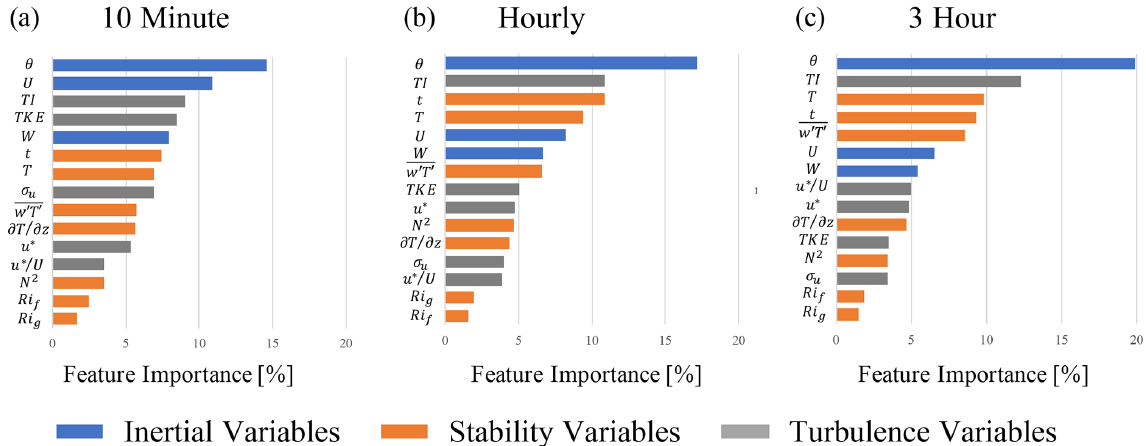
Figure 4. Feature importance for the prediction of exogenous error when all input features are given to the random forest model. Panel (a) shows importance for the 10min prediction, panel (b) shows importance for the hourly prediction, and panel (c) shows importance for the 3h prediction. Blue bars denote inertial variables, orange bars denote stability variables, and gray bars denote turbulence variables. Importance values for each test sum to 100%.